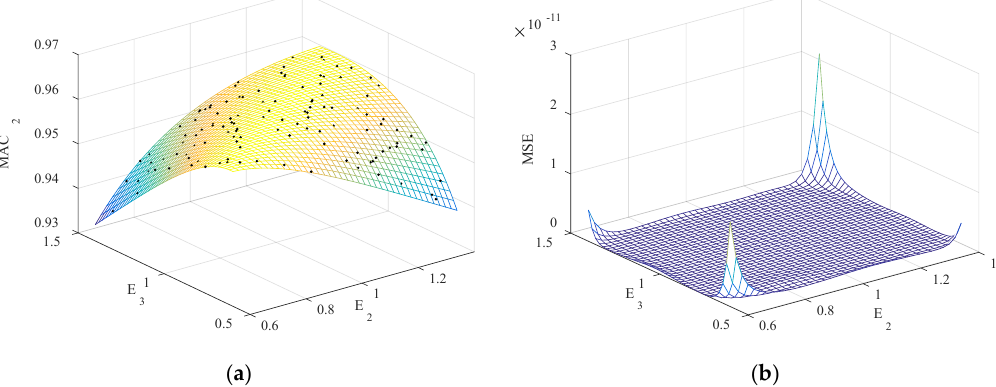
Figure 20. The value of MAC 2 in the function of E 2 and E 3 : ( a ) Kriging model and data samples; ( b ) the corresponding MSE.